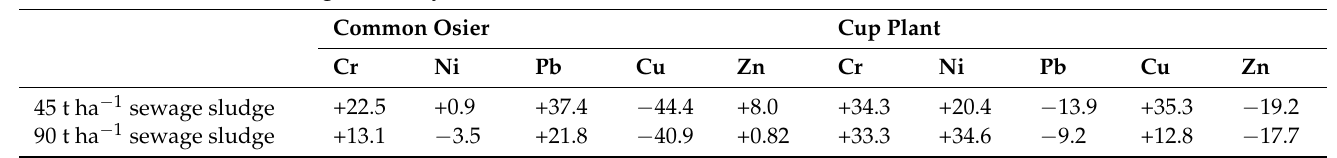
Table 3. Changes in the selected heavy metals concentrations in soil under different contamination with sewage sludge levels by growing different energy